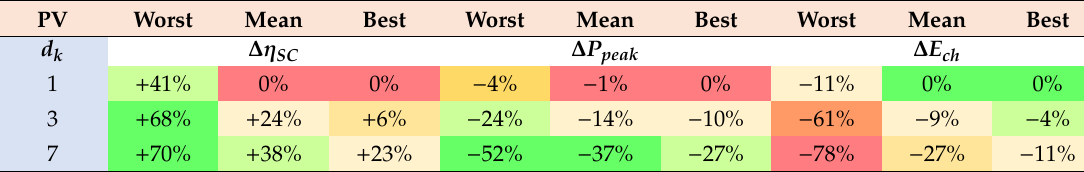
Table 6. Performance parameters’ comparison between the CMS and standard